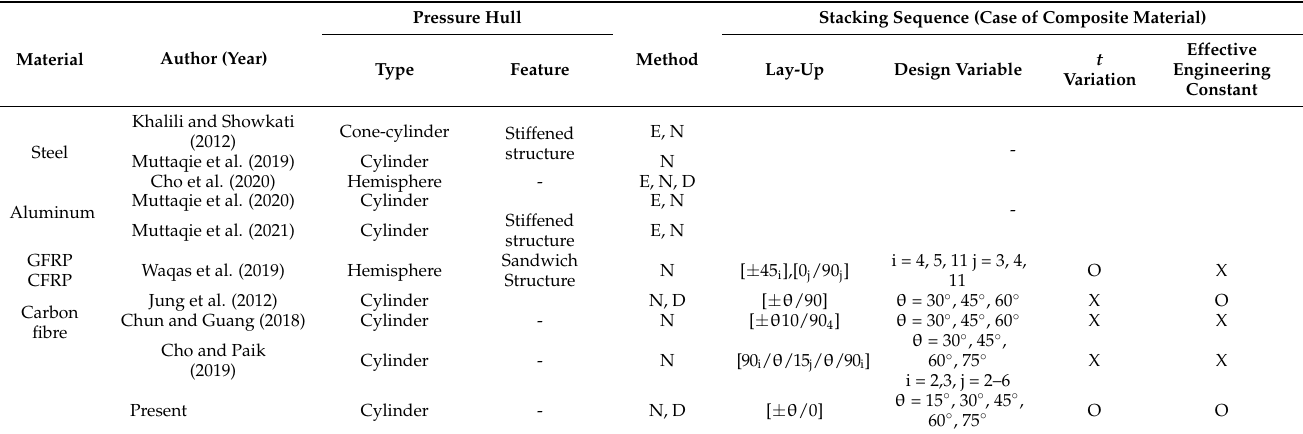
Table 1. Research publications with focus on the collapse strength of pressure hull